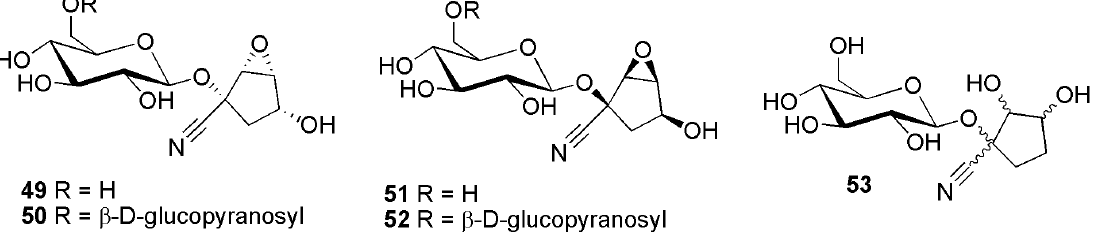
Figure 10. Cyanogenic glycosides group B-3, cyclopentane derivatives 49 – 53 : suberin A ( 49 ), 6 ′ - O - β - D -glucopyranosyl-suberin A ( 50 ), suberin B ( 51 ), 6 ′ - O - β - D -glucopyranosylsuberin B ( 52 ) and passiguatemalin ( 53 ).